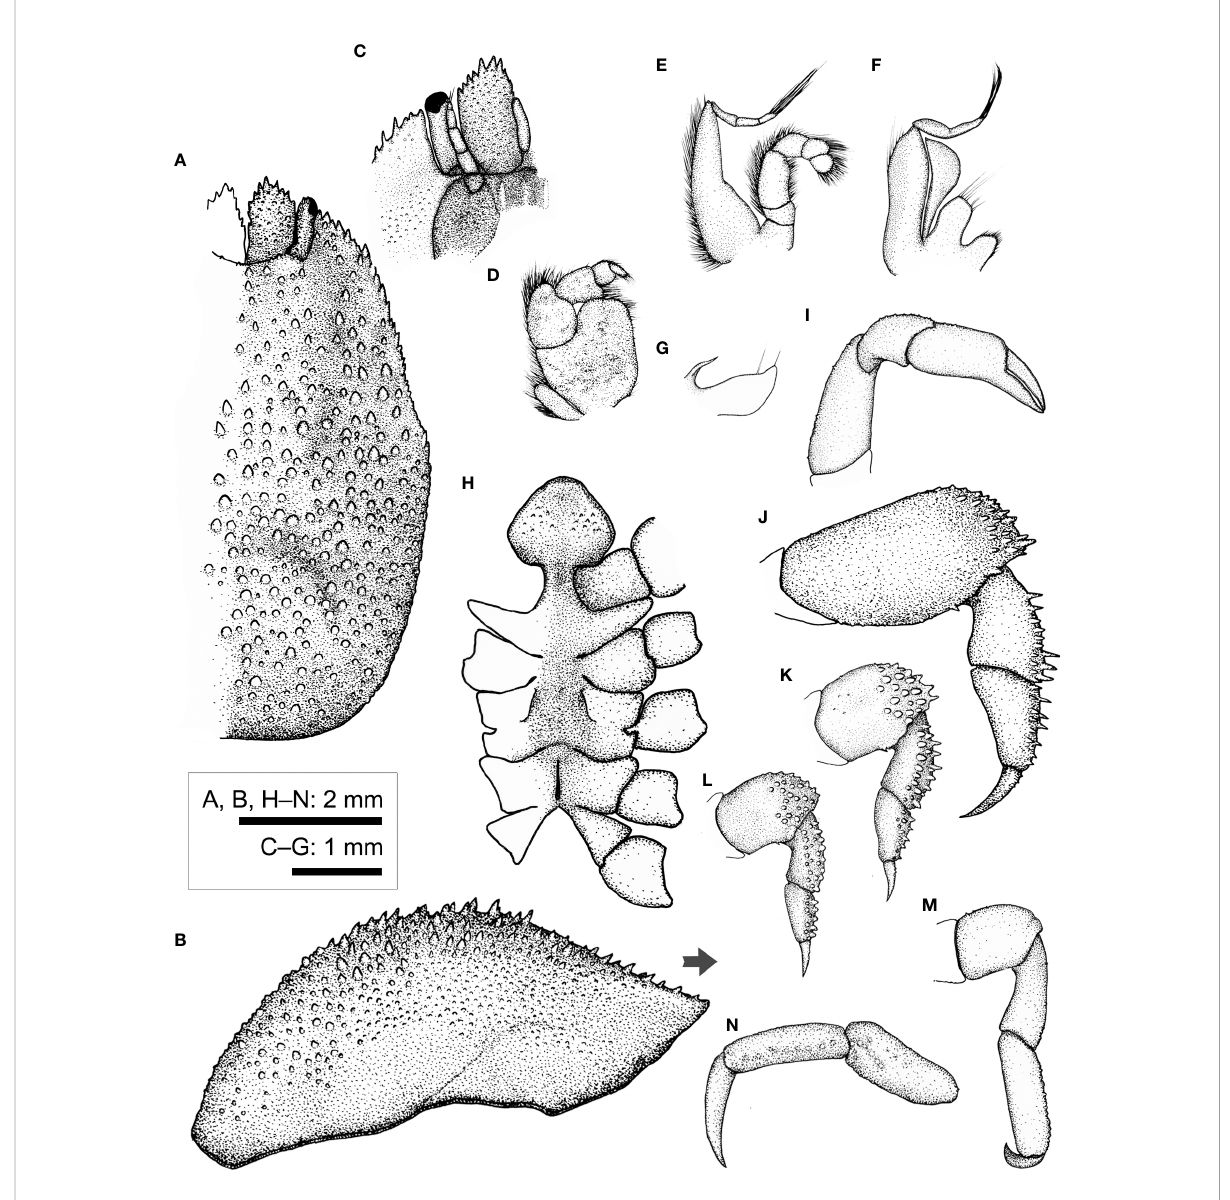
FIGURE 9 Lithoscaptus paradoxus A. Milne-Edwards, 1862, female (CEL-Hapa-007). (A) carapace, dorsal view; (B) carapace, lateral view; (C) anterior view of carapace, ventral view; (D) right Mxp3; (E) right Mxp2; (F) right Mxp1; (G) right Mxl 1; (H) thoracic sternites; (I) right P1; (J – M) right P2 to P5, dorsal view; (N) right P5, propodus and dactylus, lateral view. Arrow in (B) indicates the anterior